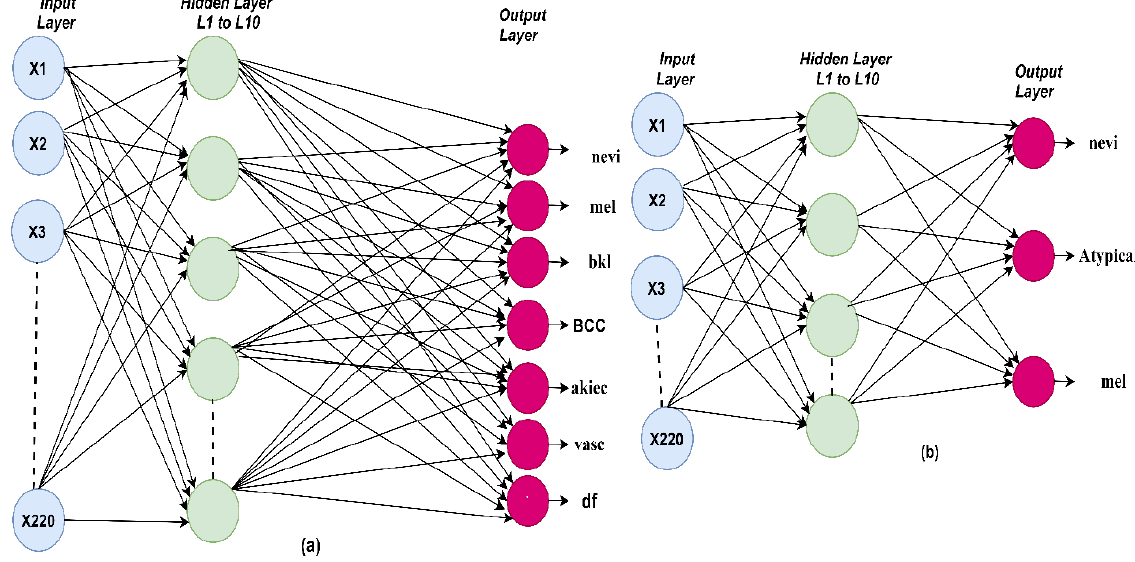
Figure 8. The architectures of the ANN and FFNN algorithms. ( a ) The architecture of ANN and FFNN from the ISIC 2018 dataset. ( b ) The architecture of ANN and FFNN from the PH2 dataset.